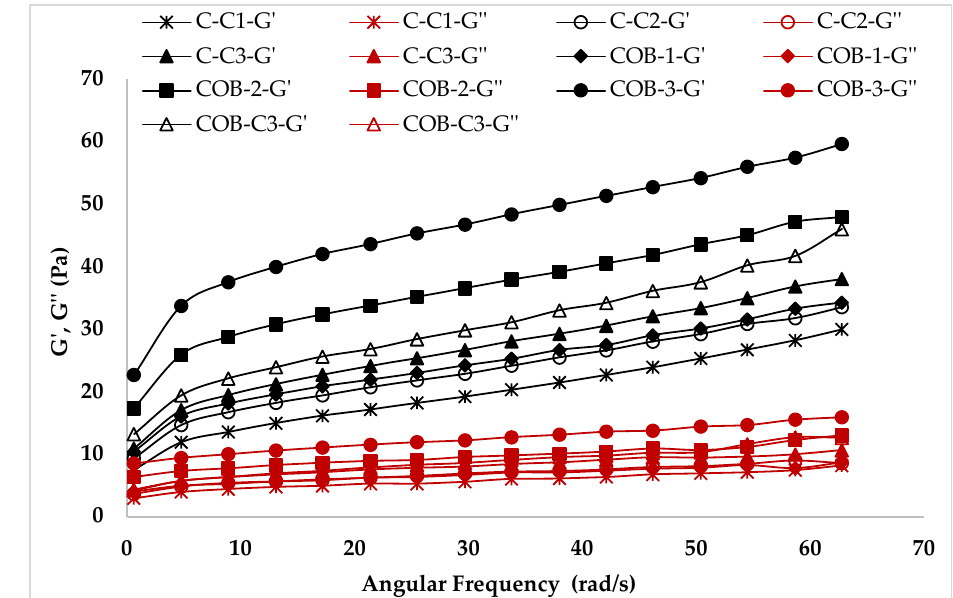
Figure 3. The dynamic rheological properties of ice cream mixes. Table 3. Dynamical rheological properties of plant-based ice cream